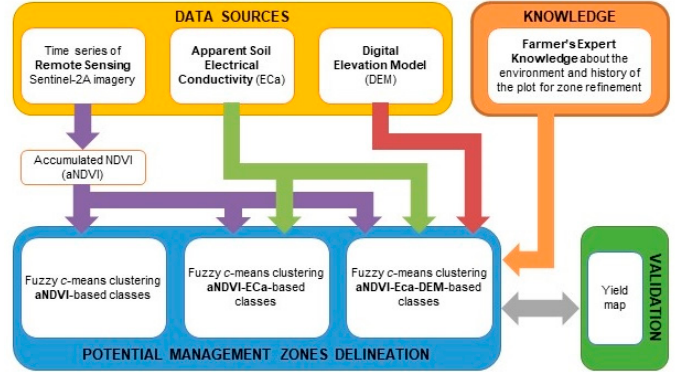
Figure 2. Summary of the methodological approach applied in the present research. This approach